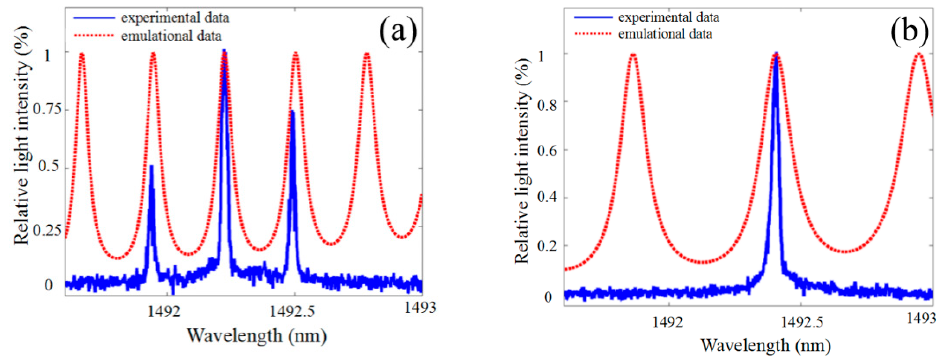
Figure 8. The output signal spectrum when F-P etalon with an air gap of ( a ) 4 mm ( b ) 2 mm.